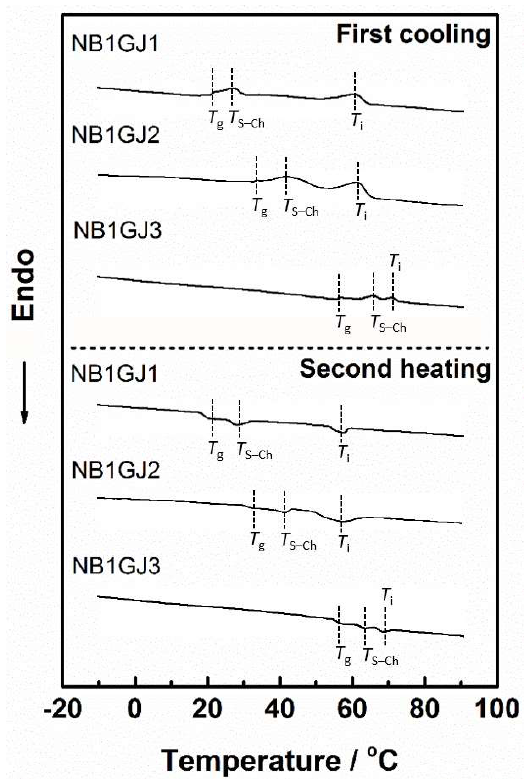
Figure 1. Differential scanning calorimetry curves of the samples during the first cooling and second heating scans at a rate of 20 °C min −1 .